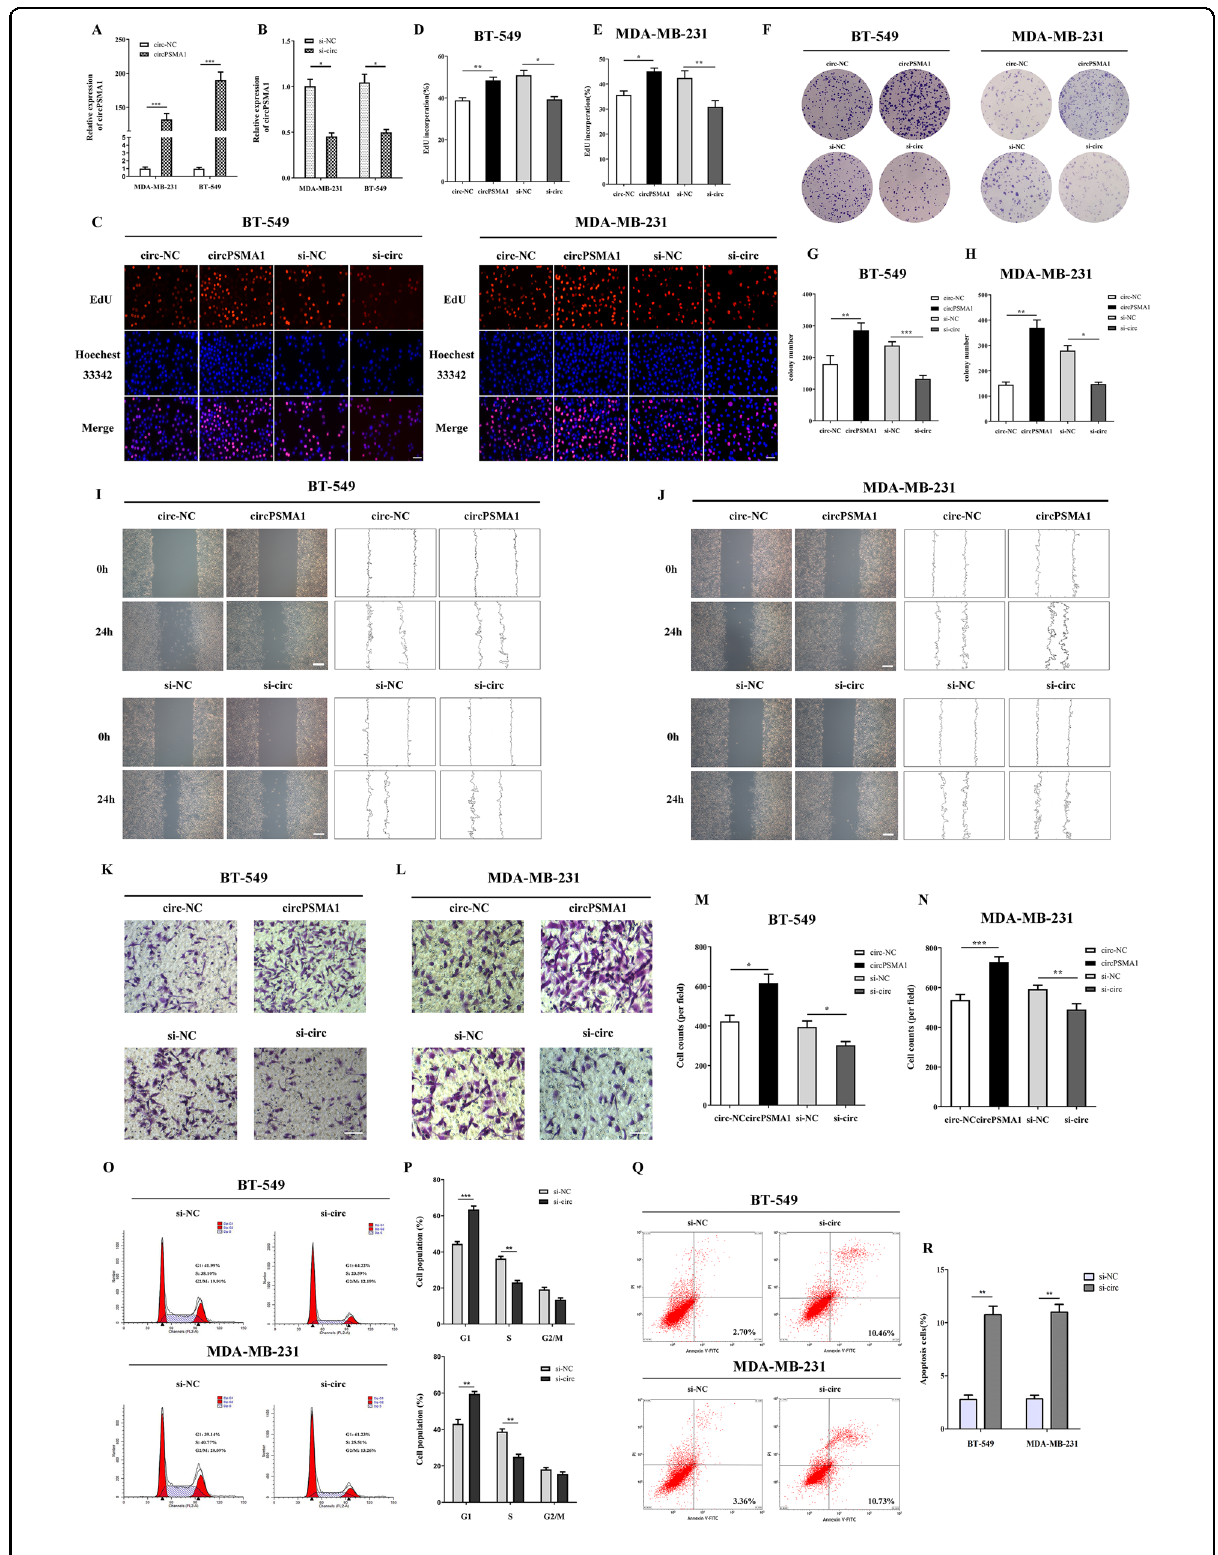
Fig. 2 (See legend on next